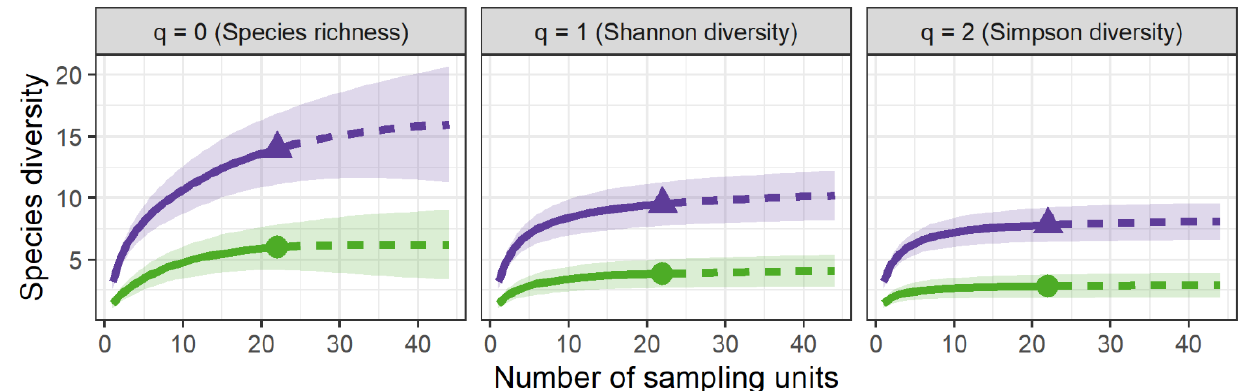
Figure 2. Empirical diversity profiles of sample size-based rarefaction (solid lines) and extrapolation (dashed lines) curves for incidence-based tree species data of top height individuals collected on control plots (green, point) and exclosure plots (purple, triangle) for Hill numbers of order q ( q = 0, species richness; q = 1, Shannon diversity; q = 2, Simpson diversity) 18 years after establishment of study plots. The 95% confidence intervals were obtained from bootstrapping based on 400 replications.